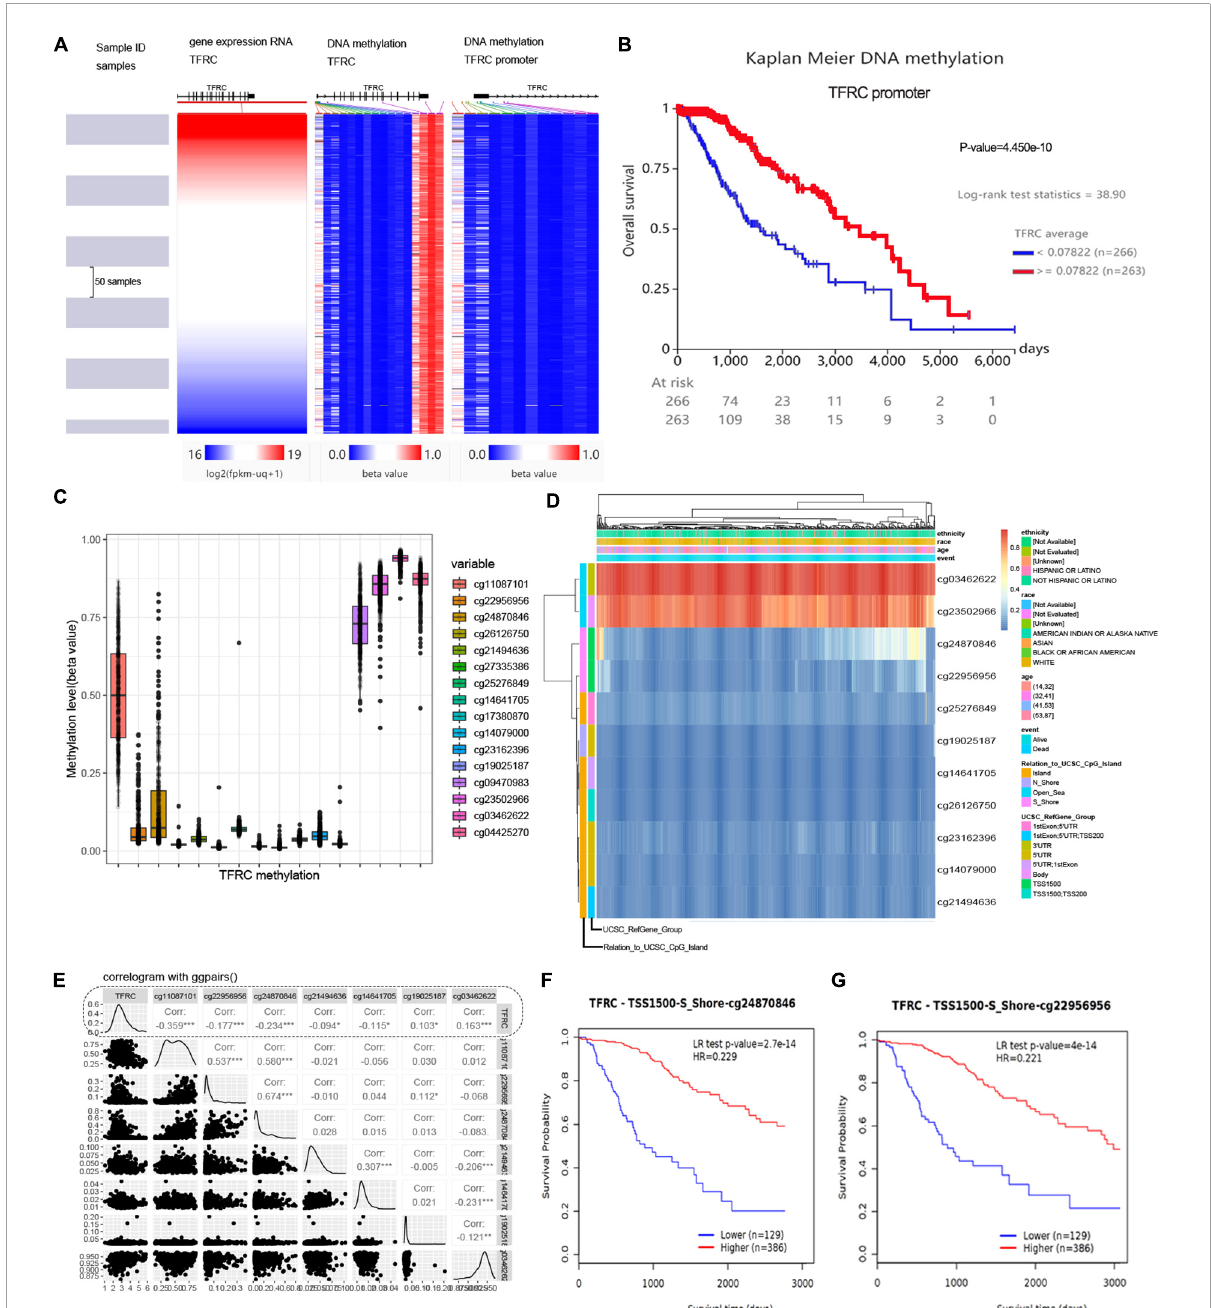
FIGURE4 The DNA hypomethylation and gene expression of TFRC in LGG. (A) The UCSC Xena shows the gene expression and methylation level. (B) Survival analysis in TFRC promoter region. (C,D) Methylation levels of DNA sites in the presence of genomic regions and clinicopathological information. (E) Hypomethylation of the TFRC promoter region was negatively correlated with gene expression. (F,G) Kaplan–Meier survival curve in methylation of TFRC promoter region. * p < 0.05, *** p <